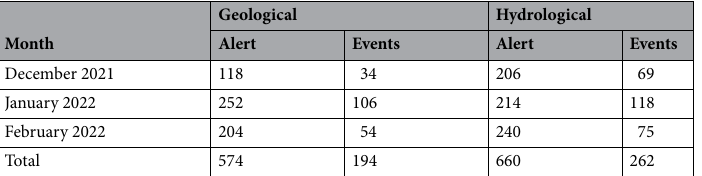
Table 2. Number of “Alerts and Events” that occurred in Southeast Brazil during the summer of 2021/2022, issued by the National Center for Monitoring and Early Warning of Natural Disasters (CEMADEN) in www. cemad en. gov. br.